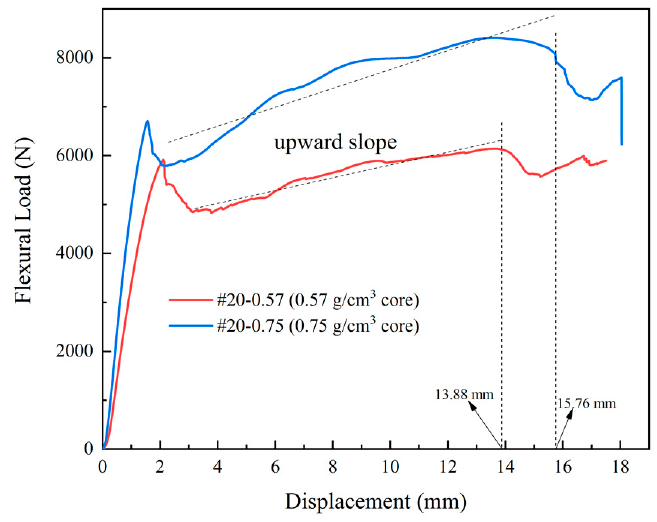
Figure 6. Analysis of flexural load–displacement curves of #20-0.57 and #20-0.75.